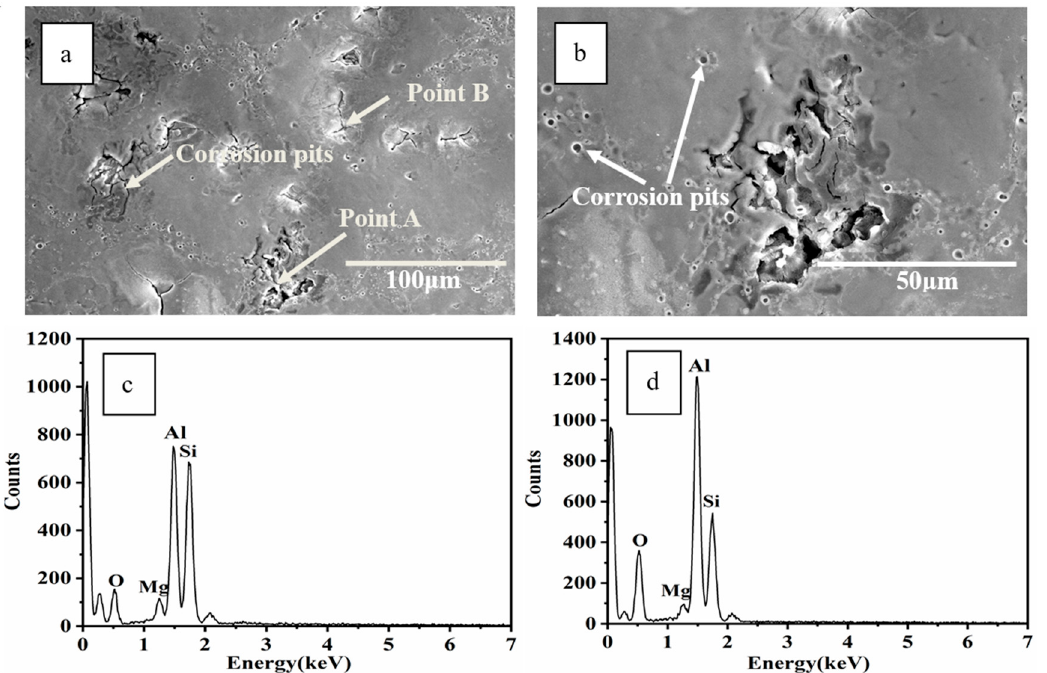
Figure 10. Surface morphology of 25-pulse-treated Al–20Si–5Mg alloy surfaces after electrochemical corrosion testing. ( a ) Low magnification micrograph; ( b ) high magnification micrograph, enlarged micrograph of Figure 10a; ( c ) EDS profile of point A in Figure 10a; ( d ) EDS profile of point B in Figure 10a.